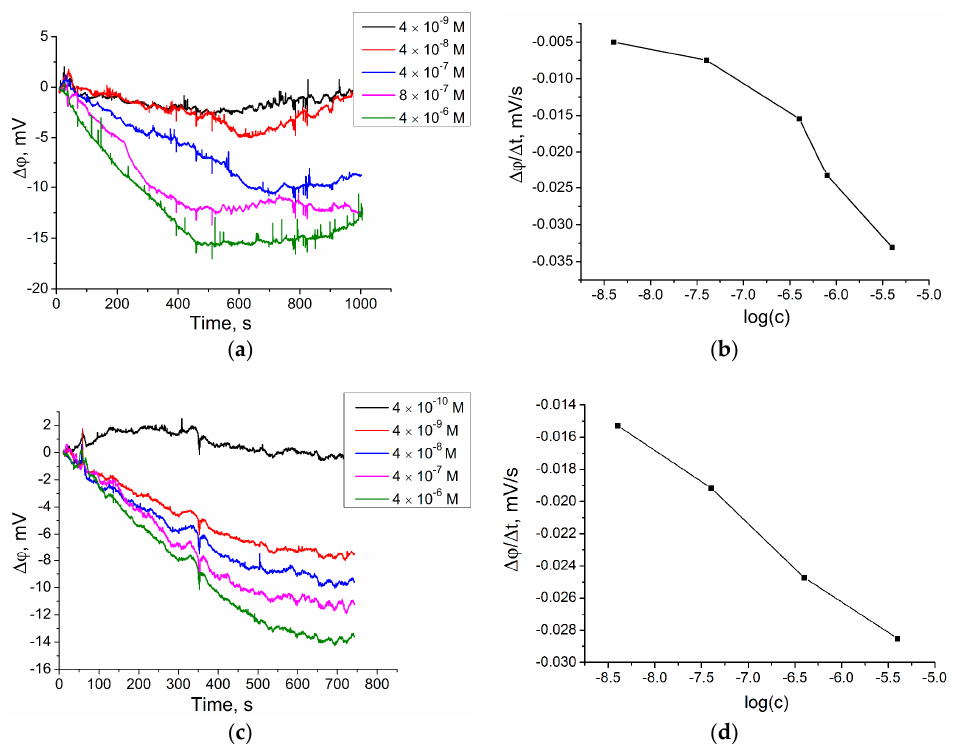
Figure 5. ( a ) Real time signal of the ISFET (in ∆ϕ , with background subtraction) during the Bsm DNA polymerase reaction in homogenous solution in low molarity selection buffer initiated (30–40 s) by the addition of DP at different concentrations (final concentration is marked on the picture); ( b ) Slope ( ∆ϕ / ∆ t) dependence on DP concentration calculated from real time signal curves. Reaction conditions: 0.2 mM dNTP, 0.05 pmol/µL FP, 1.6 pmol/µL PR, 0.1 U/µL BSM DNA polymerase; ( c ) Real time